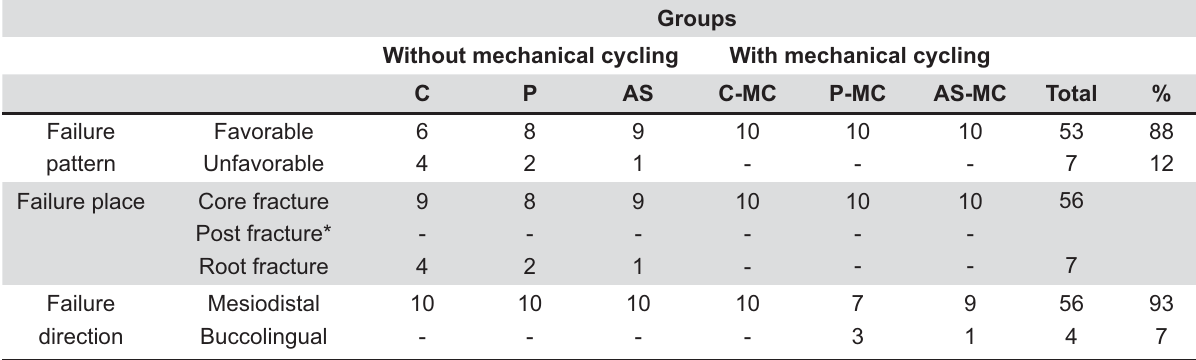
Table 4- Qualitative analysis of failure patterns after the fracture resistance test